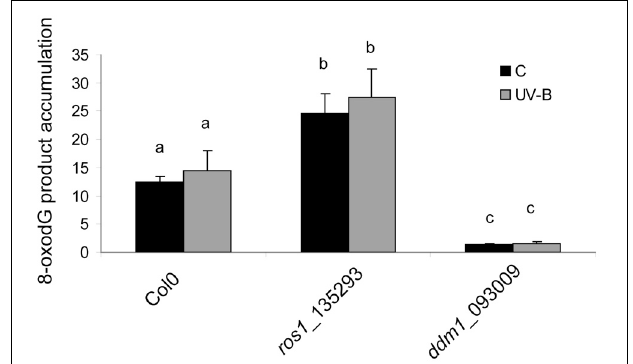
FIGURE 5 | 8-oxodG levels in the DNA of Col0, ros1 and ddm1 arabidopsis plants. Plants were assayed under control conditions (C) and after a 4h UV-B treatment (UV-B). Results represent the average ± S.E.M. of six independent biological replicates. Different letters denote statistical differences applying ANOVA tests using Sigma Stat